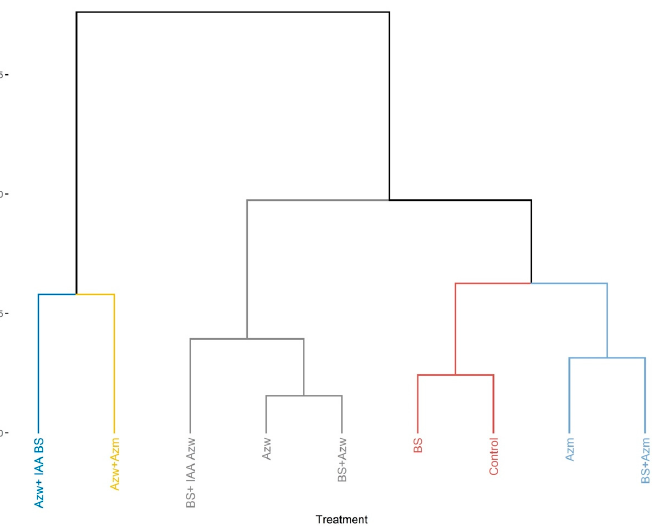
Figure 6. Hierarchical clustering of principal components ( HCPCs ) of inoculations tested for the Entire genotype. Entire